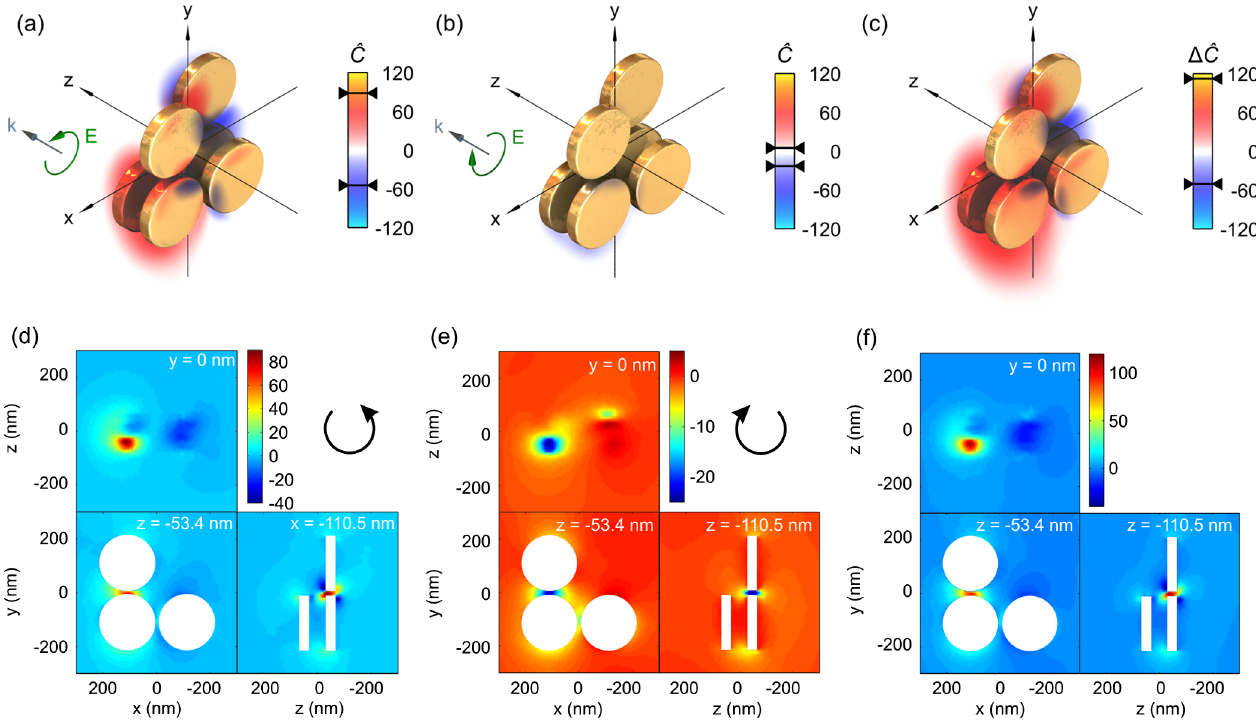
FIG. 10. Optical chirality enhancement of the chiral oligomer for incident (a),(d) LCP and (b),(e) RCP light at a wavelength of 900 nm. The spatial points with strongest enhancement can be found on similar spatial locations but exhibit different signs, which leads ^ C . (d)–(f) Slices through the point between the top and bottom left disk of the front layer show that to (c),(f) a very strong difference (cid:1) the region with strongest enhancement is located in the gap between these two